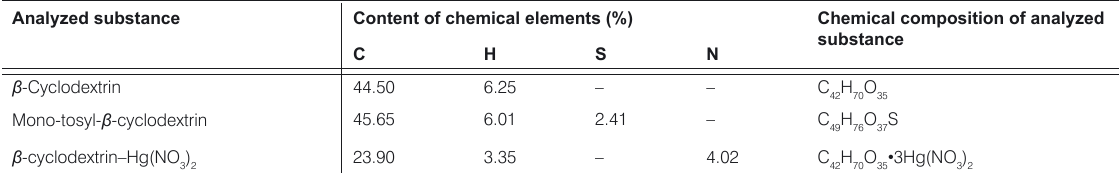
Table 1. Elemental analysis of β -cyclodextrins and inclusion complex β -cyclodextrins with mercury(II)